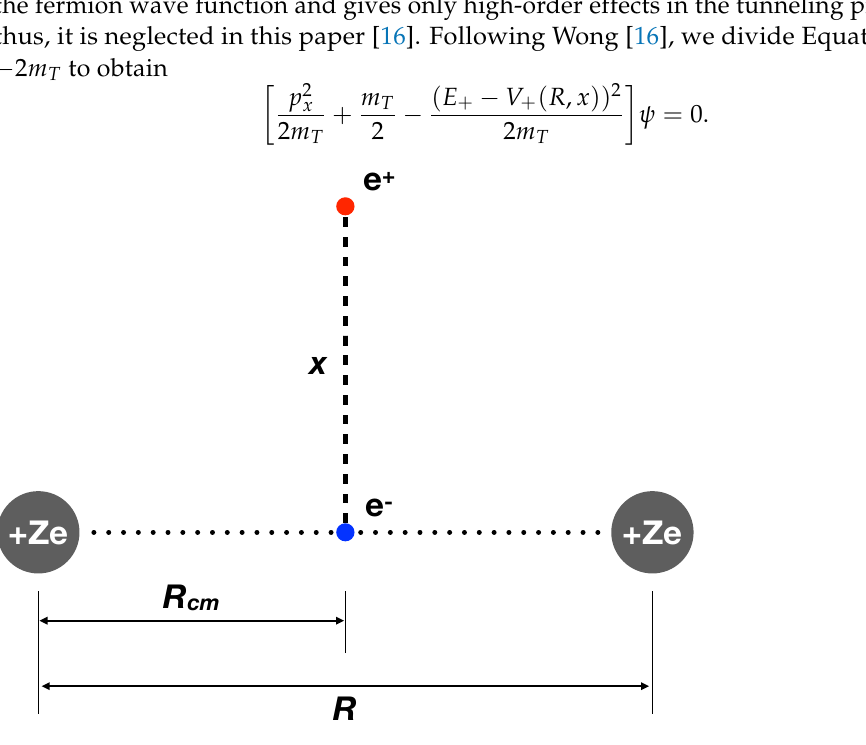
Figure 1. (Color online) Geometry of the pair